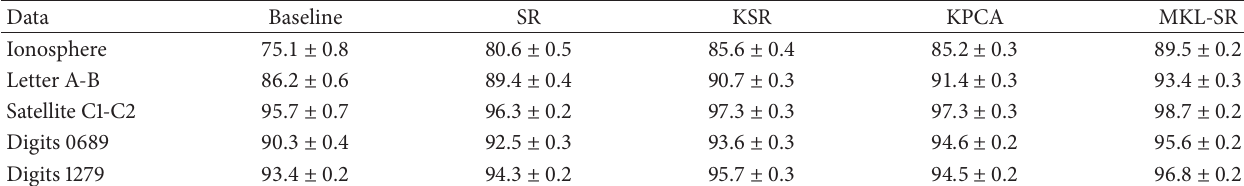
Table 2: Clustering accuracy (in percent) based on different DR methods.